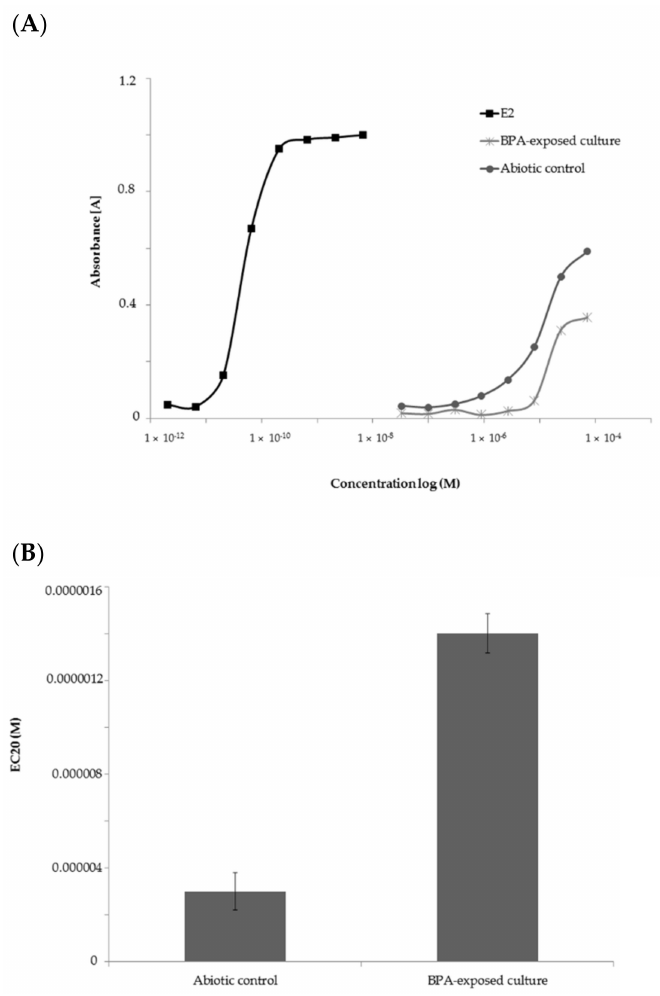
Figure 4. ( A ) ER dose-response curves and ( B ) EC20 (M) values for extracts of abiotic control and M. roridum IM 6482 culture cultivated in Czapek-Dox III medium containing the addition of BPA (50 mg · L − 1